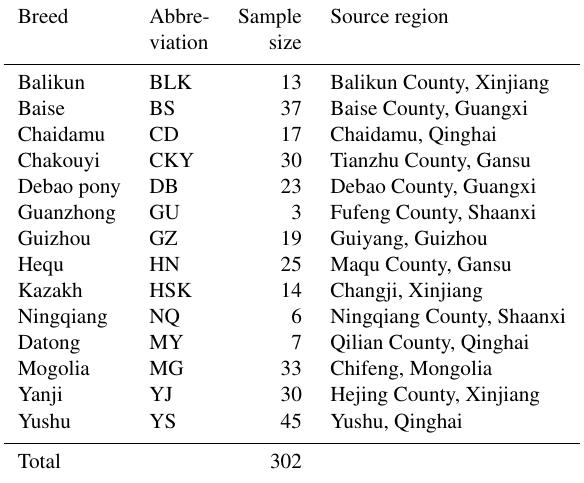
Table 1. Sample information for the 14 chosen Chinese horse breeds.